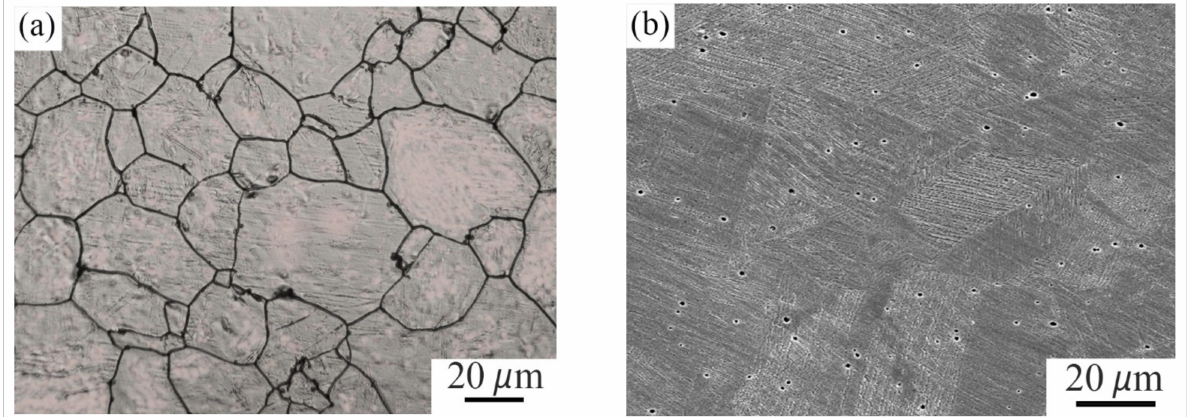
Figure 3. ( a ) Optical micrograph of the SS304L base metal, ( b ) secondary electron micrograph of the SS304L base